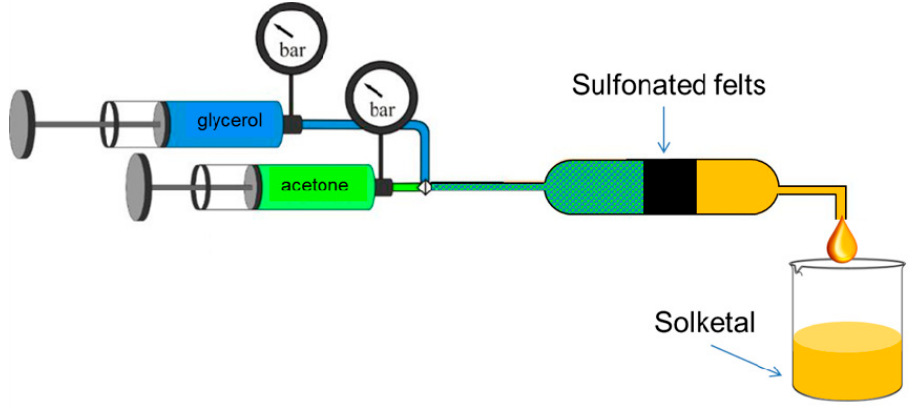
Figure 12. Experimental set-up for continuous production of solketal in a flow reactor.